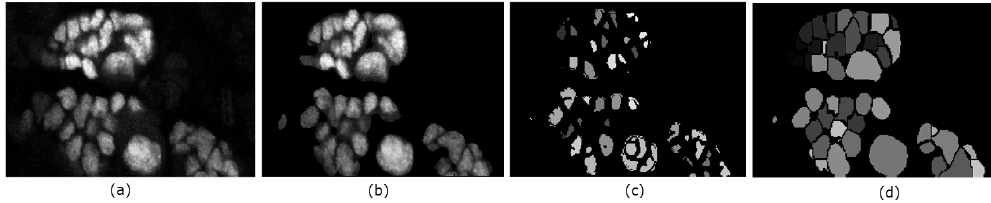
Figure 6. Illustration of the key steps in the proposed segmentation method. Panel ( a ) is a slice of the original volume to be segmented; ( b ) is the resulting foreground from the chan-vese method; In panel ( c ) the obtained seeds are shown; while the resulting segmentation is shown in ( d